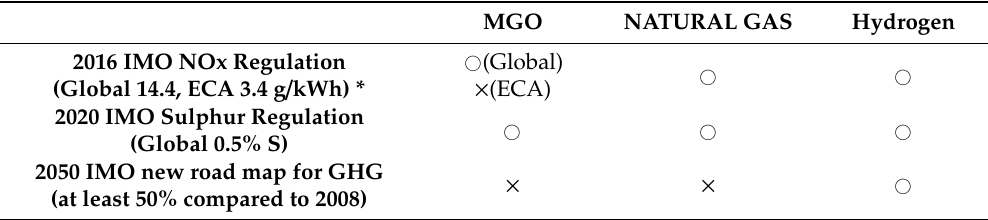
Table 6. Comparison of compliance to the International Maritime Organization (IMO) regulations for ship emissions.